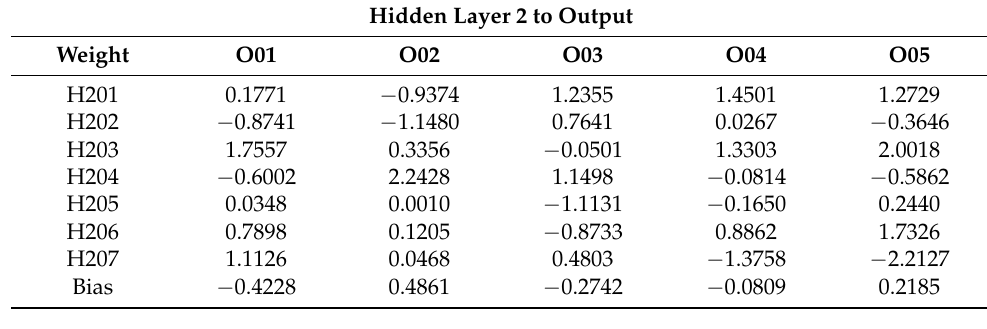
Table 28. Weight and bias between the second hidden layer and the output layer (CAE-1024).